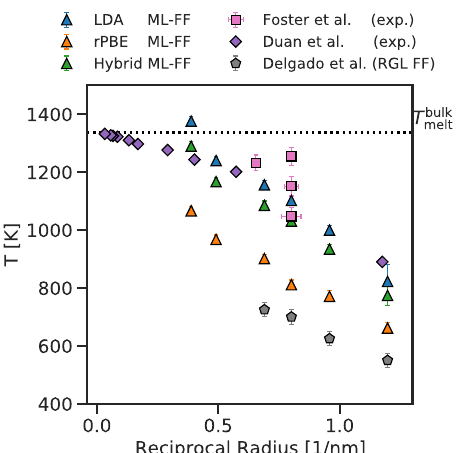
as Fig. 2 Melting temperatures of Au NPs of different sizes. Average T NP melt a function of NP ’ s reciprocal radius computed for MD simulations employing the LDA-trained (blue triangles), rPBE-trained (orange triangles) and hybrid (green triangles) ML-FFs. Experimental data for size-selected Au NPs supported on carbon (pink squares) and spherical Au NPs (purple diamonds) are taken from Foster et al. 38 and Duan et al. 39 , respectively. Grey pentagons refer to the T NP estimates from TB-SMA iterative MD melt melting simulations from Delgado-Callico et al. 13 . Error bars indicate the standard deviation of the melting temperature estimations, and of the NP sizes for experimental data taken from Foster et al. 38 (pink